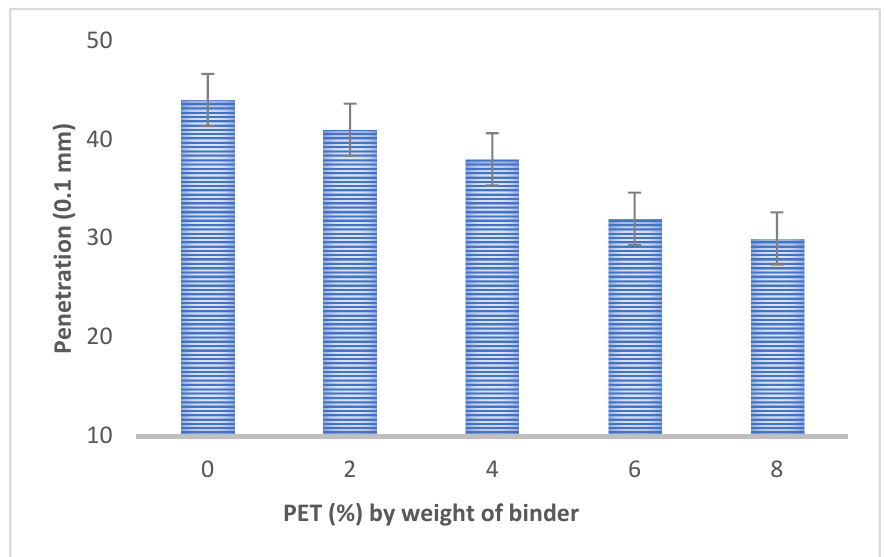
Figure 3. Results for the penetration of unaged PET-modified bitumen.